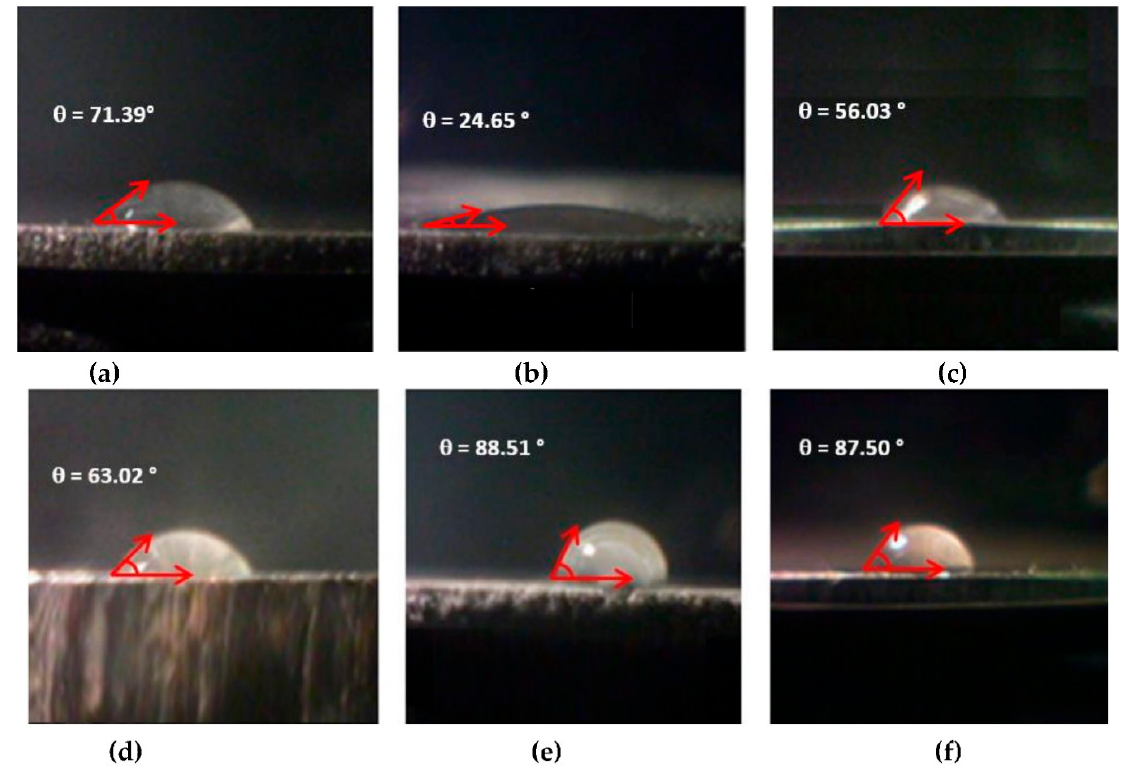
Figure 8. CA of θ w and θ Y of ( a ) Ti, ( b ) Ti-OH, ( c ) Ti-AEMAC, ( d ) Ti-GTMAC, ( e ) Ti-AUTEAB, and ( f ) Ti-OA specimens. Reprinted with permission from [68]. Copyright 2021 MDPI. Distributed under Creative Commons Attribution-based license (CCBY 4.0.).